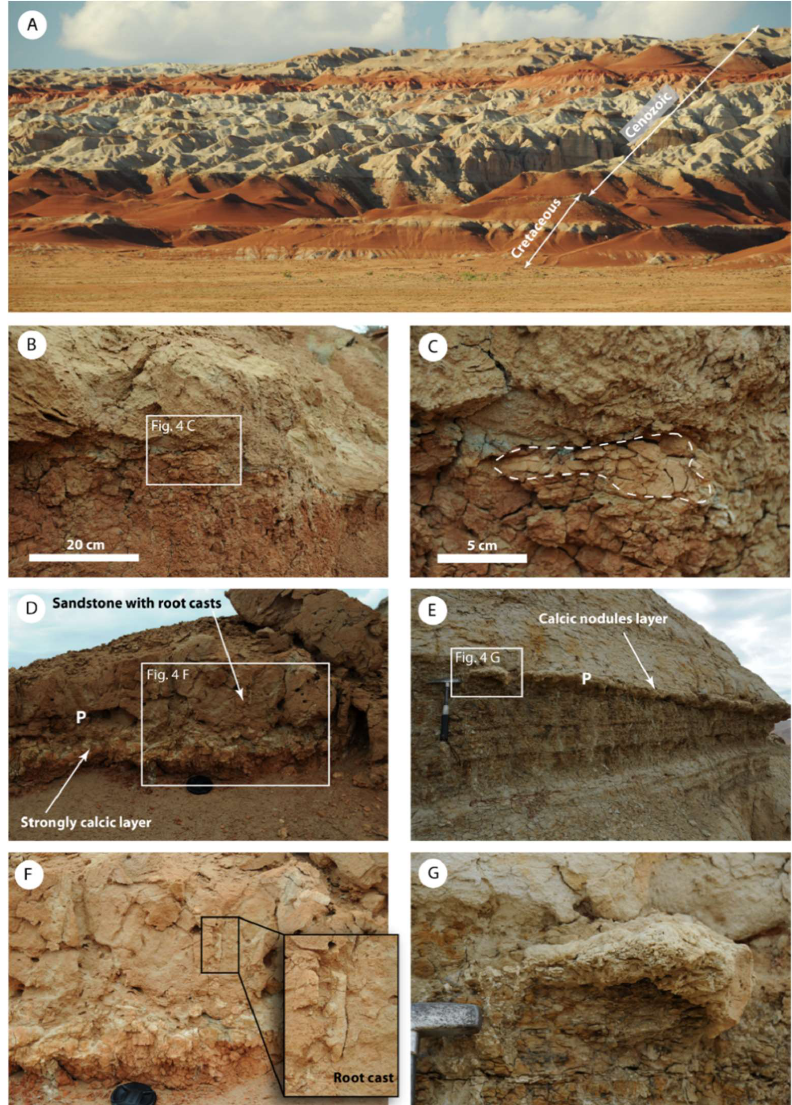
Figure 4. ( A ) General view of the Central Junggar Canyon section (the distance between the bottom and the top of the section is about 1 km). ( B , C ) Calcareous nodules forming the Late Cretaceous paleosols. ( D ) Quaternary paleosol layer including individual root casts (detail on F ). ( E ) Quaternary paleosol formed by near coalescent calcareous nodules (detail on G ).